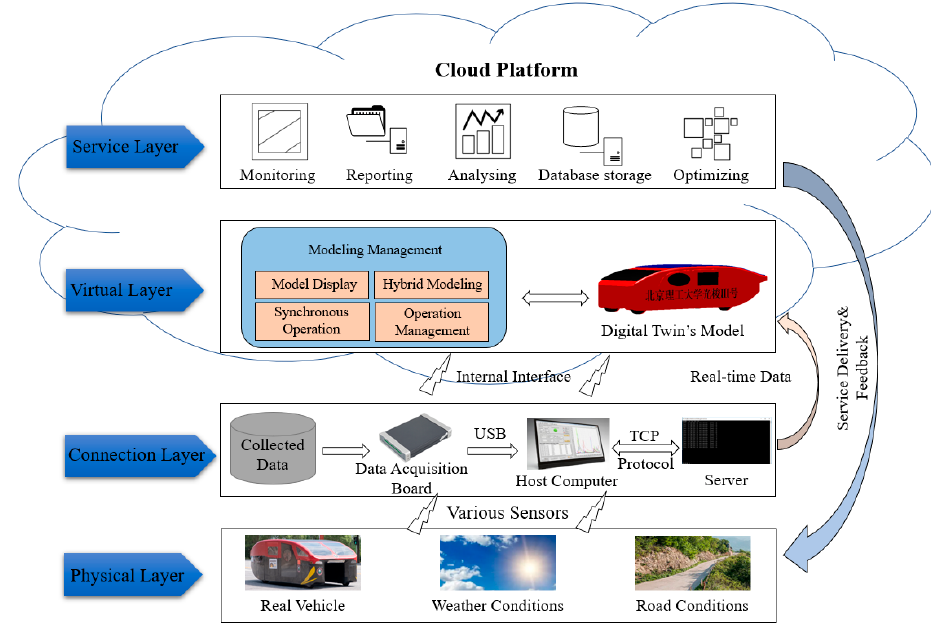
Figure 1. Elements of the presented architecture.